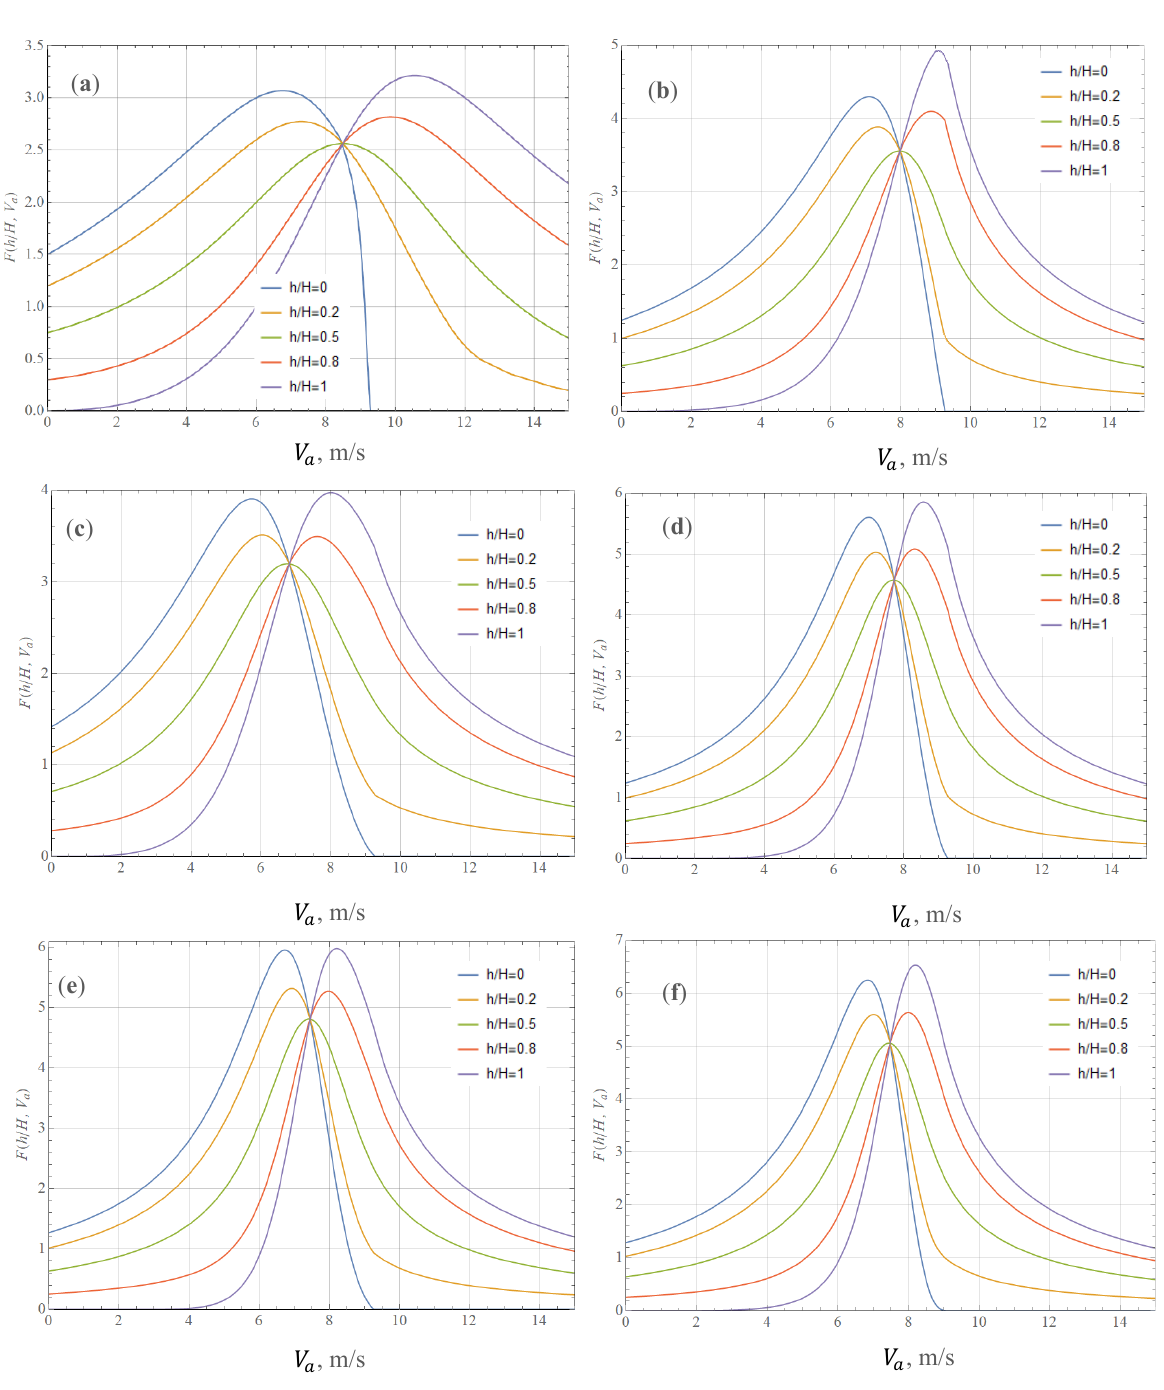
Figure 5. Dimensionless pressure drop in the shaft vs. the air velocity for different depths of the water inflow source: ( a ) uniform distribution (4); ( b ) Best (7); ( c ) Marshal–Palmer (8); ( d ) Laws–Parsons (9); ( e ) Feingold–Levin (10); ( f ) Rosin–Rammler (11).